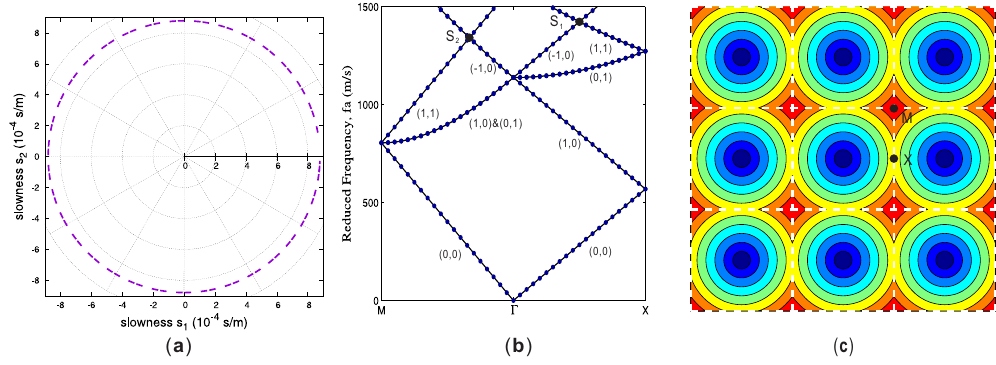
Figure 2. Empty lattice model for out-of-plane polarized waves in epoxy. ( a ) The slowness curve is a circle in this case. ( b ) The empty-lattice band structure for the out-of-plane polarized waves of epoxy is shown. Numerical and analytical results are shown with solid circles and lines, respectively. Each branch is labeled by an index corresponding to the reciprocal lattice point from which the generating cone originates. Points S 1 and S 2 are examples of intersections between branches located inside the first Brillouin zone (BZ). ( c ) Isofrequency curves are plotted for the first band. The white dashed lines mark the first intersection between cones centered at adjacent reciprocal lattice